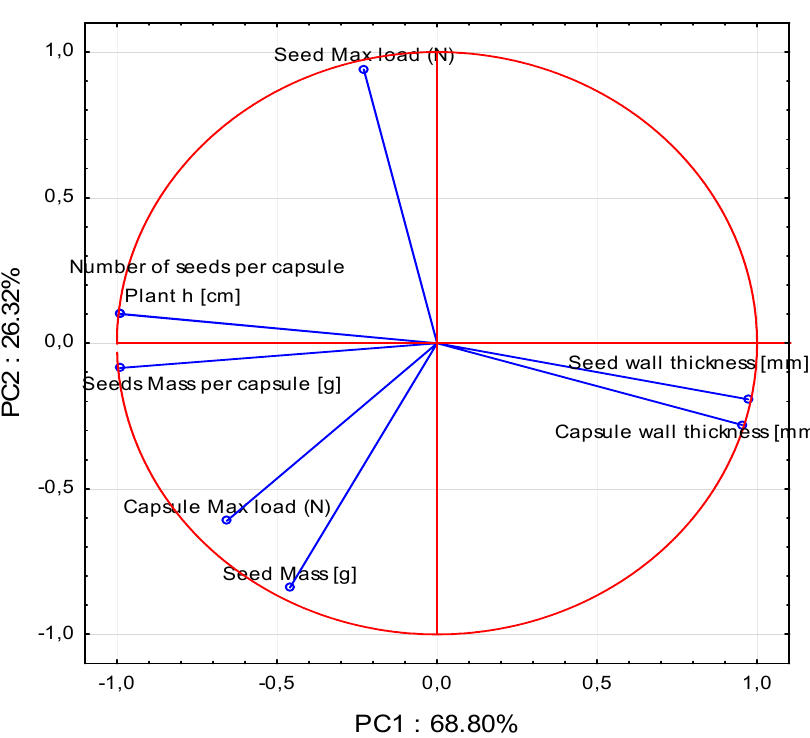
Figure 5. Graph of variables (Plant h [cm]. Seed mass per capsule [g]. Number of seeds per capsule. Seed wall thickness [mm]. Seed mass [g]. Capsule wall thickness [mm]. Capsule max load (N). Seed max load (N)). Position of load vectors relative to the first two PCA